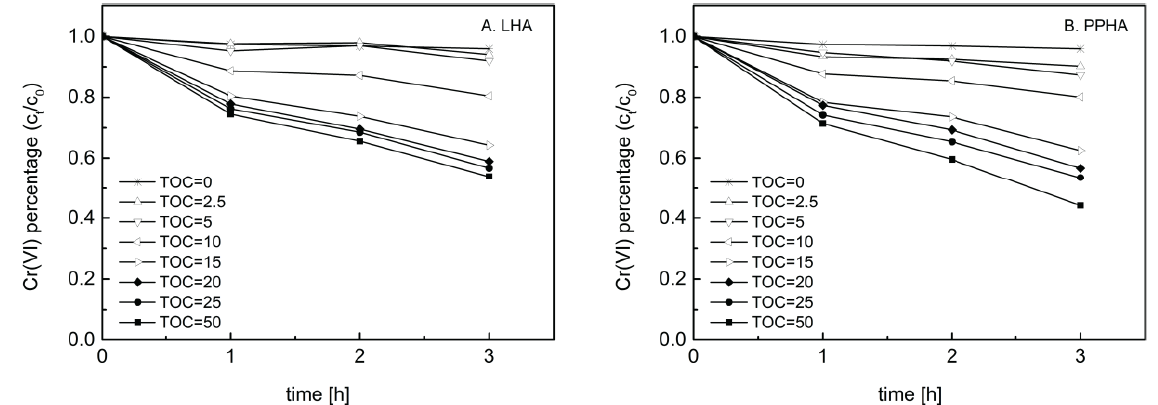
Figure 1. Influence of TOC concentrations of HA samples (2.5, 5, 10, 15, 20, 25, 50 mg C/L) on Cr(VI) reduction by Shewanella oneidensis MR-1. ( A ) LHA; ( B ) PPHA.